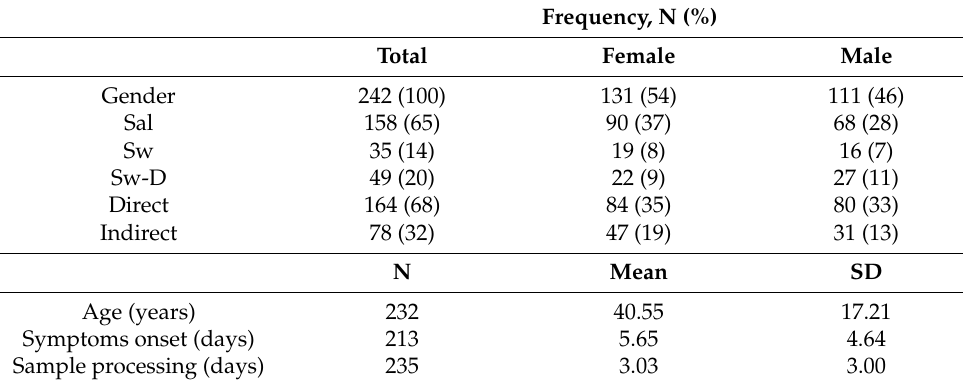
Table 1. General characteristics of patients and collected